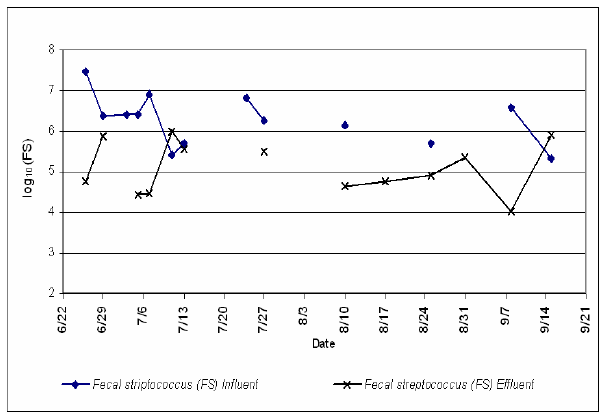
Figure 3: Fecal streptococcus in AWWTP influent and effluent Fecal